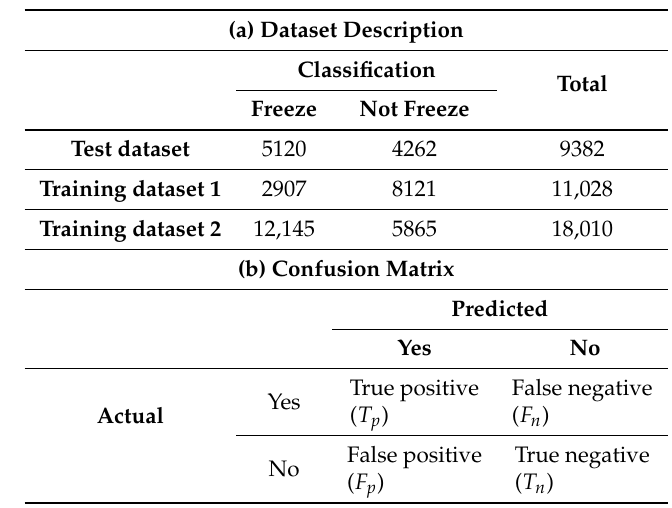
Table 3. Description of the dataset and confusion